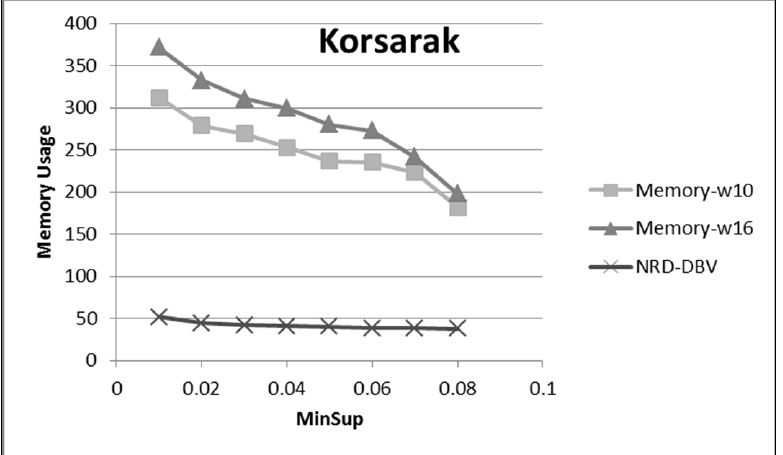
Figure 12. Comparison of memory usage for the TRuleGrowth with the NRD-DBV algorithm for (Korsarak) dataset .